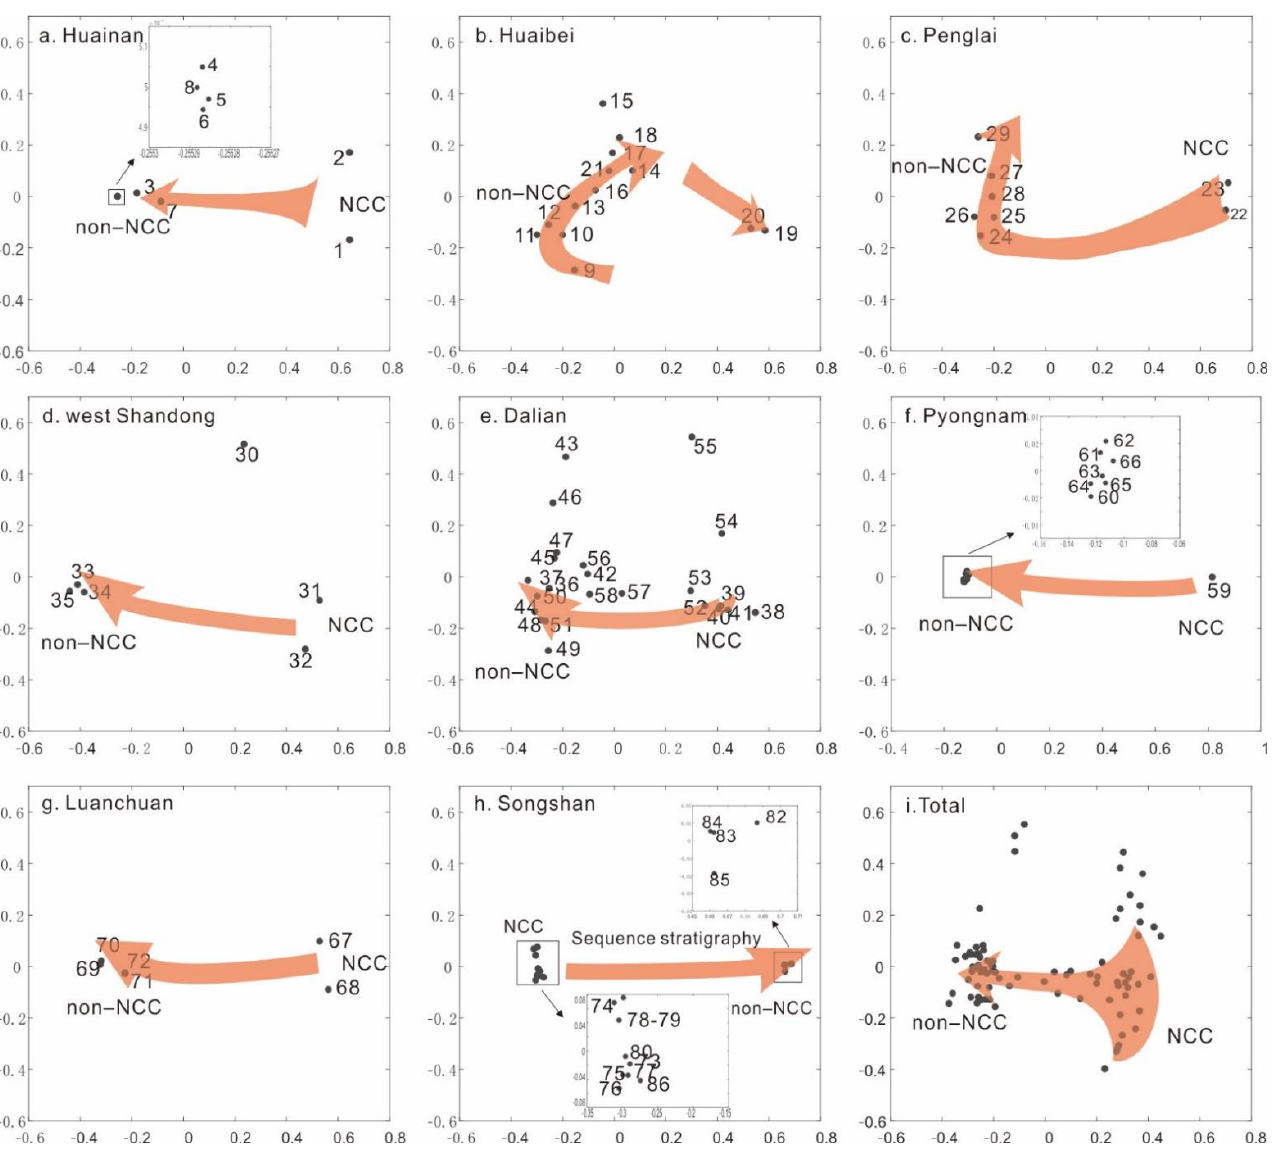
Figure 8. Multidimensional Scaling plots of existing samples from the early Neoproterozoic succes- sions in south-southeast NCC [26]. The serial number of the samples are the same as in Figure 2.